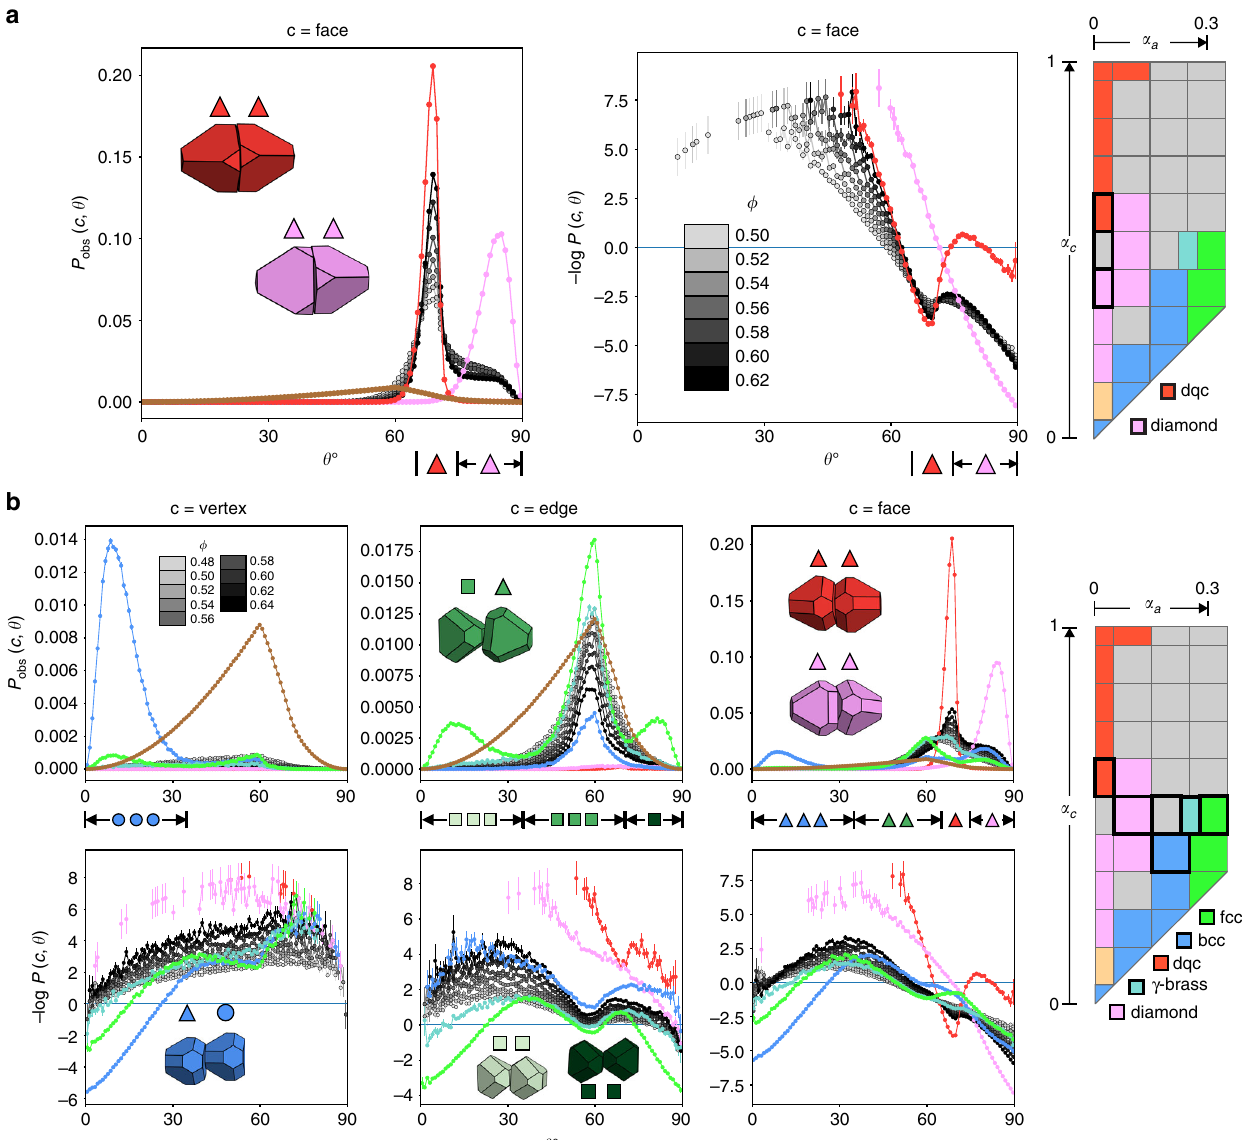
Fig. 3 Competition of structural motifs in two example glass-formers. Competing pairwise motifs dominate in ordered structures self-assembled from shapes nearby in shape space. Panels show probabilities of observing certain pairwise con fi gurations, P obs ( c , θ ), and the negative log of the normalized distributions, − log P ( c , θ ), for disordered systems at the indicated densities and nearby crystals at ϕ = 0.62 (or ϕ = 0.6 for γ -brass). Error bars are calculated in a manner detailed in the Motif identi fi cation section of the Methods. a Competition between face-connected aligned and twisted motifs at ( α a , α c ) = (0, 0.5). Motifs are prevalent in nearby diamond and dodecagonal quasicrystal (dqc) structures. b Competition between face-connected aligned and twisted motifs and a face-edge connected motif at ( α a , α c ) = (0.2, 0.5). Motifs are prevalent in nearby diamond, dqc, fcc , and γ -brass